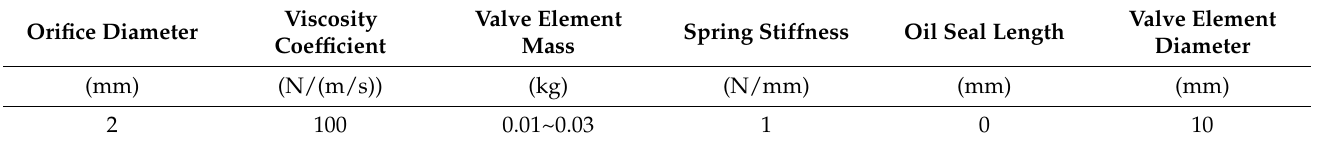
Table 3. Simulation parameters—group